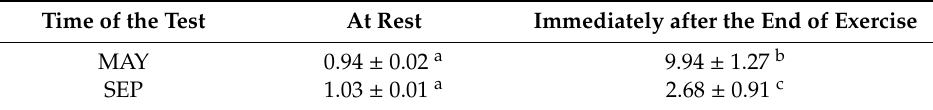
Table 3. Plasma lactic acid concentration in studied racehorses (lsm ± SE).